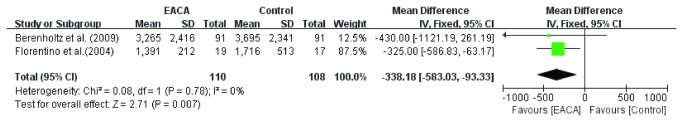
The weighted mean difference (WMD) estimate for total blood loss.